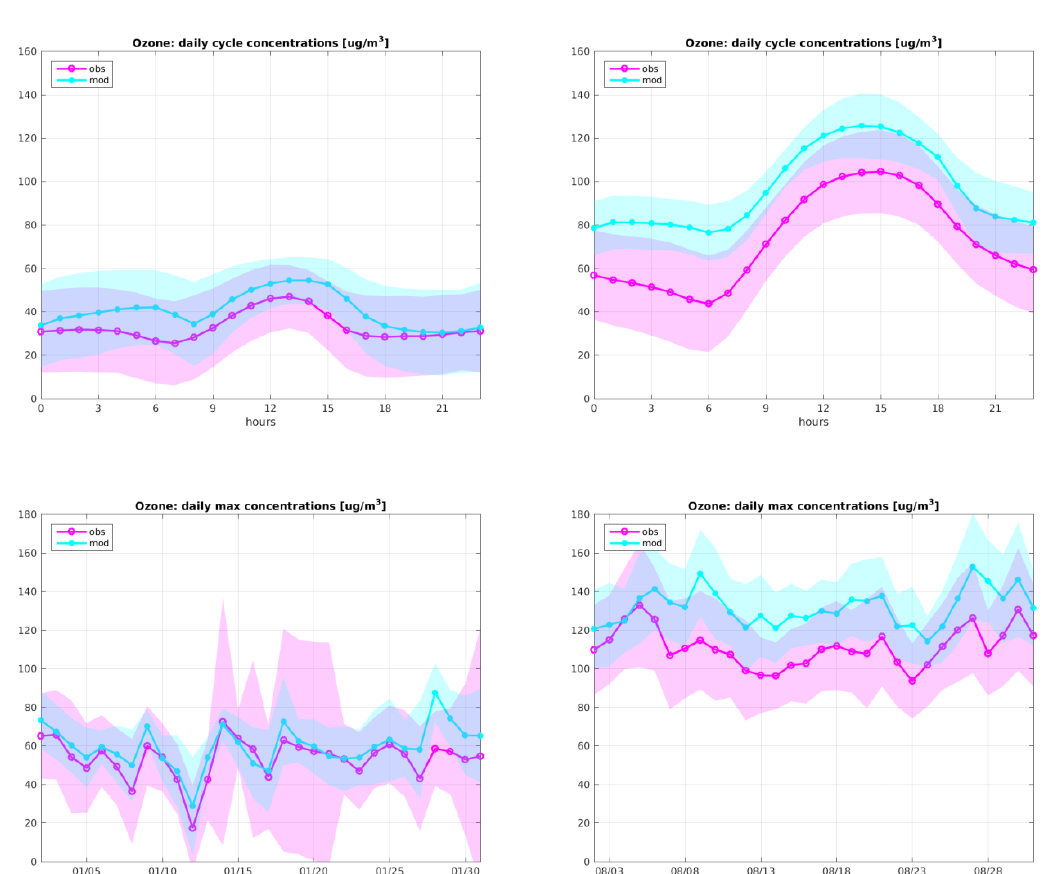
Figure 4. O 3 —observed (violet) and modelled (light blue) average daily cycle of hourly concentrations (upper panel) and average daily maximum of hourly concentrations (lower panel), for January (left) and August (right). The dotted line is the average on all stations, coloured strip is in the range of the 25th–75th percentiles of the values at stations. The x -axis reports UTC times.